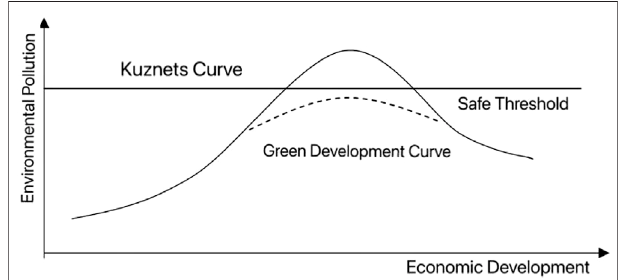
FIGURE 1 | Environmental Kuznets